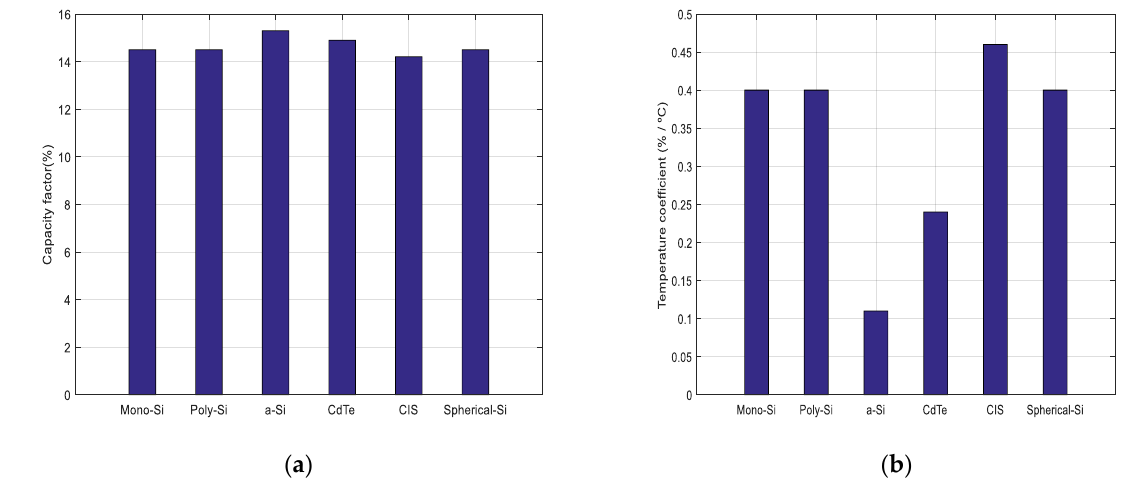
Figure 7. ( a ) Capacity factor. ( b ) Temperature sensitivities of various PV technologies in RET- Screen.